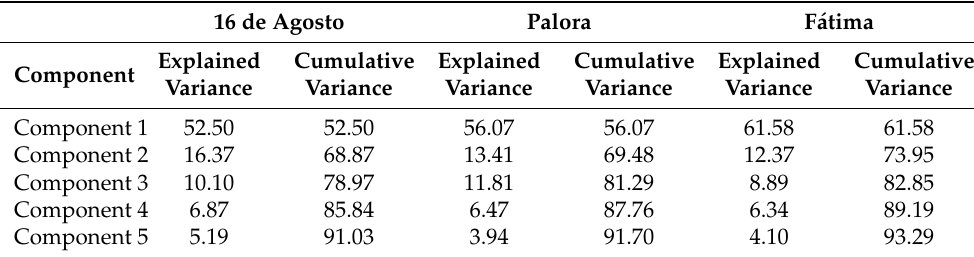
Table 2. Cumulative variance explained by components in the three environments of this study. The variance explained by each component and the cumulative variance are presented. With five components around 90% of the variance is explained in all environments. 16 de Agosto Palora F á tima Explained Cumulative Explained Cumulative Explained Cumulative Component Variance Variance Variance Variance Variance Variance Component 1 52.50